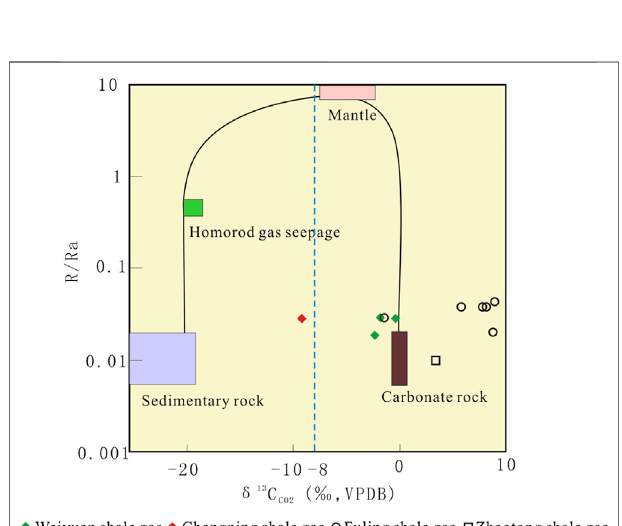
FIGURE 8 | Comparison diagram of natural gas R/Ra − δ 13 C CO2 in the Sichuan Basin (Modi fi ed after Etiope et al., 2011).